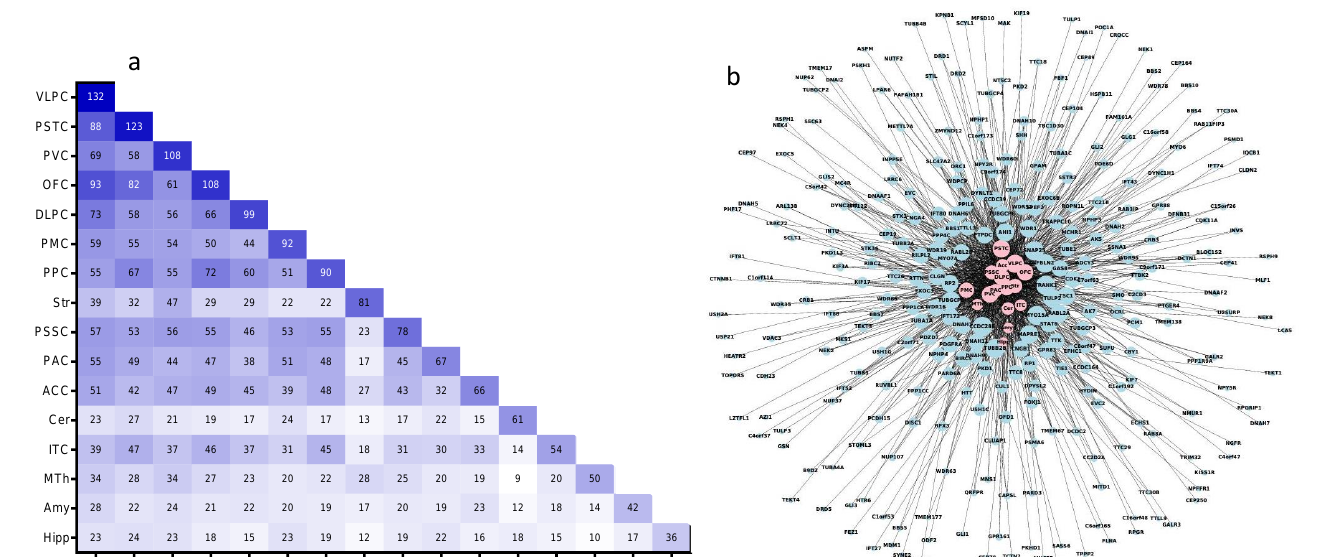
A wide expression overlap of age-regulated cilia transcripts among brain regions was observed (Figure 3a,b). Only 93 cilia transcripts exhibited a unique age-regulated pattern in a single brain region (Figure 3a,b). We screened cilia transcripts that exhibited age-dependent expressions in multiple brain regions and found that CCDC28B was the only cilia DEGA common across all brain regions. However, CCDC28B age-dependent expression patterns differed across brain regions [27,28], being downregulated in 12 and upregulated in four brain regions.